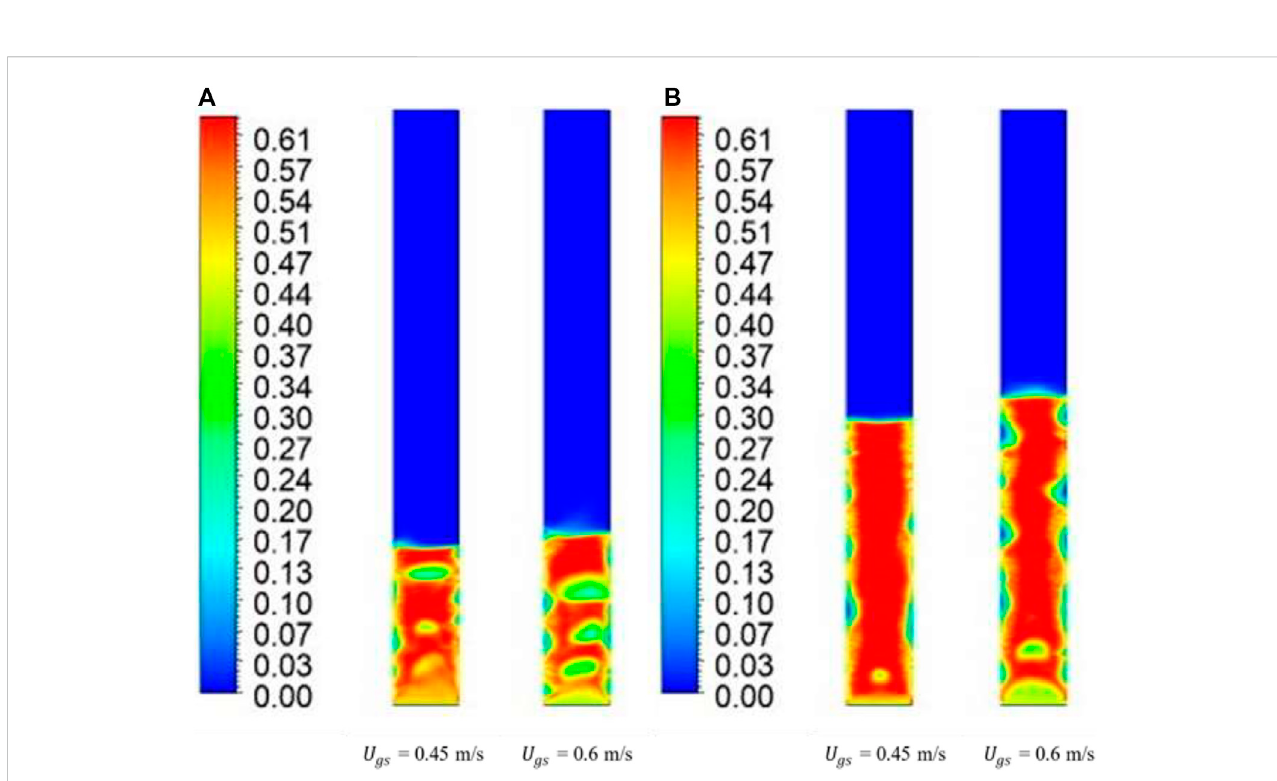
FIGURE 11 Time-averaged steady-state solid-phase volume fraction contours for 100% mixture at (A) 0.335 m bed height and (B) 0.635 m bed